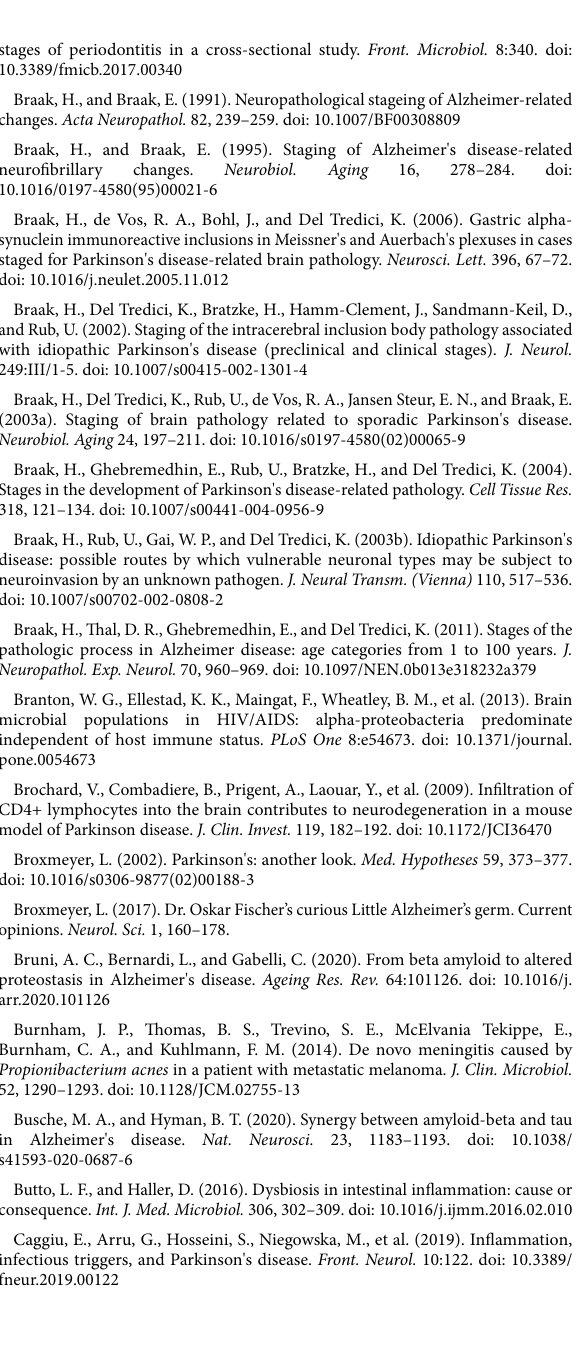
SUPPLEMENTARY FIGURE 5 (A) Real-time PCR displayed to compare between controls and disease and (B) comparison between samples of ≤ 40 and > 40 h post mortem interval (PMI). Brain regions did not show significant effect on 16S rRNA DNA levels with disease state or post-mortem interval (PMI) except for the temporal BA21/22 area, which had increased bacterial DNA levels in those with PMIs > 40 h PMI. AD, Alzheimer’s disease; C, Control (no dementia); PD, Parkinson’s disease; BA, Brodmann area; PMI, post mortem interval. Human brain areas: anterior temporal cortex BA38 (AT), entorhinal cortex BA34 (EC), hippocampus (H), locus coeruleus (LC), orbito-frontal/